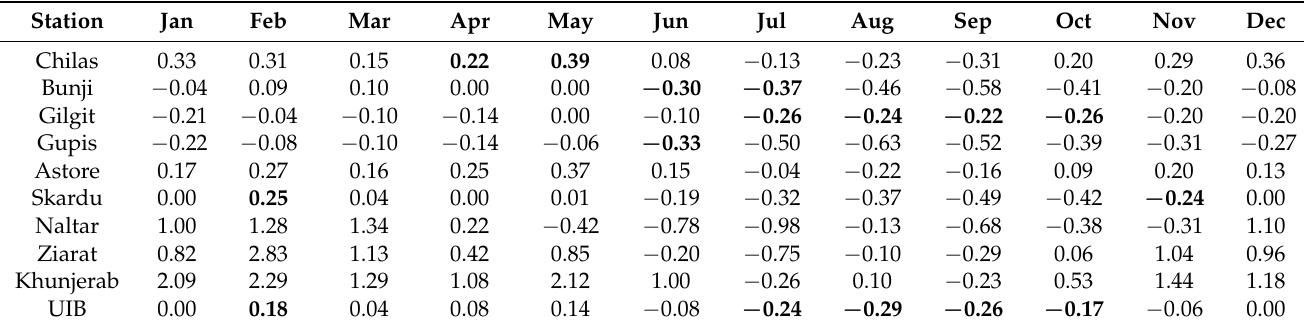
Table 3. Sen’s estimator for monthly T min ( ◦ C/decade). Bold indicates significant trend at 5% level.